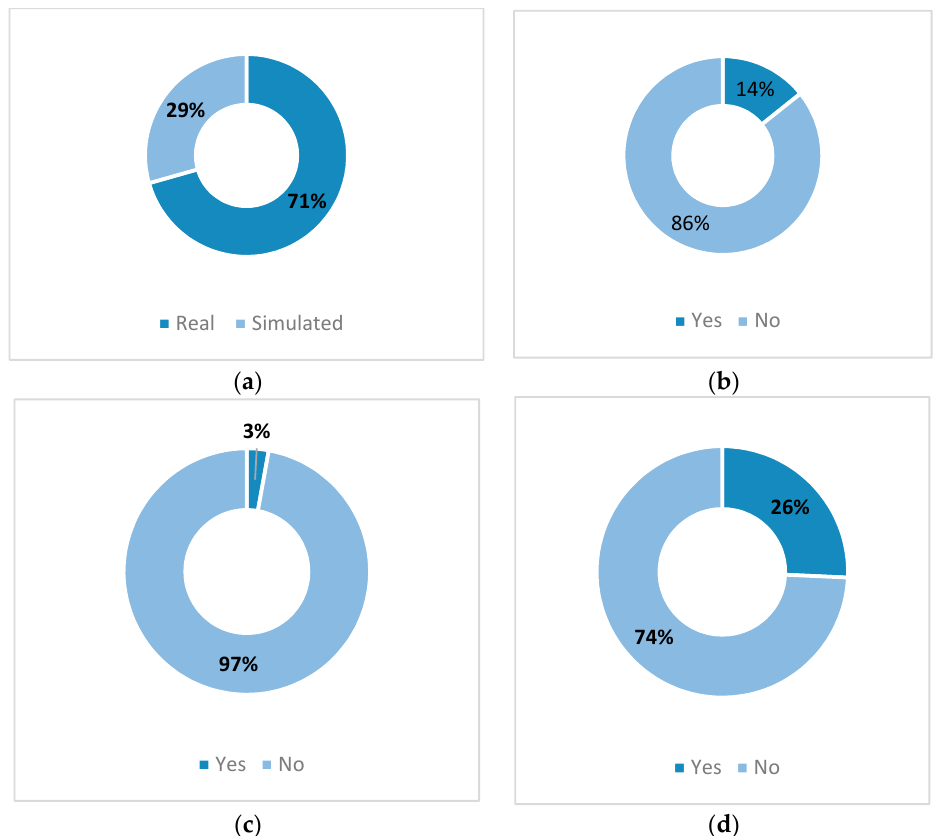
Figure 11. ( a ) Distribution of the type of case study in the selected articles; ( b ) distribution of human involvement (yes/no) in the selected articles; ( c ) distribution of explanation metric inclusion (yes/no) in the selected articles; and ( d ) distribution of uncertainty management inclusion (yes/no) in the selected